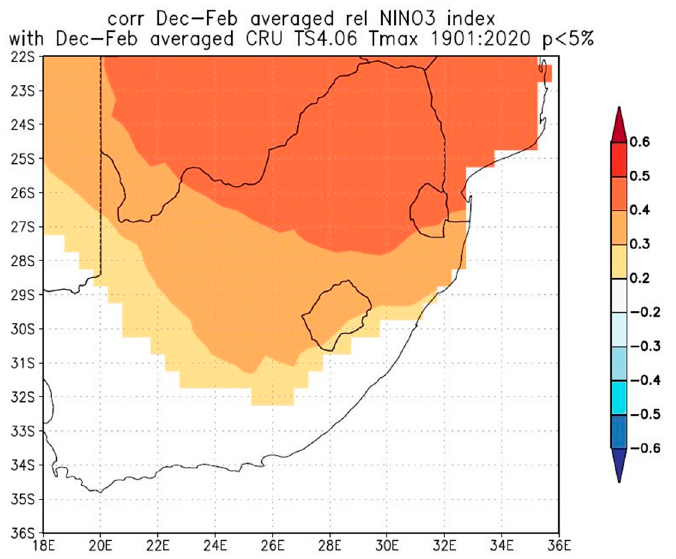
Figure 5. Seasonal correlation of the December–February (Dec–Feb) Niño 3.4 sea surface temperature and maximum temperature at a 95% significance level over South Africa from 1981 to 2020.